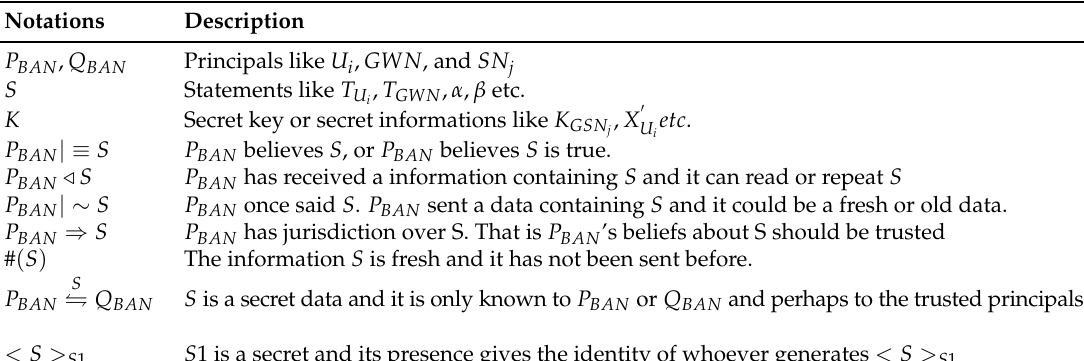
Table 21. Notations used in verification using BAN logic.